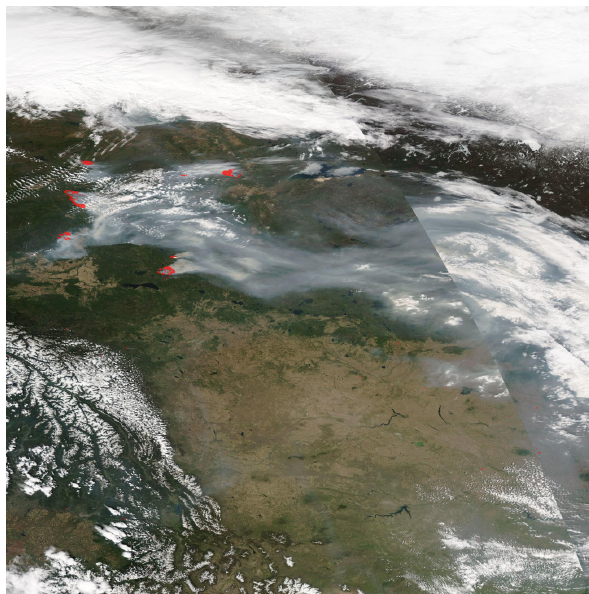
Figure A5. Smoke plume captured by Aqua MODIS for the Cana- dian fire event on 29 May 2019 (source: https://gibs.earthdata.nasa. gov, last access: 7 August 2019). The red regions indicate fires and thermal